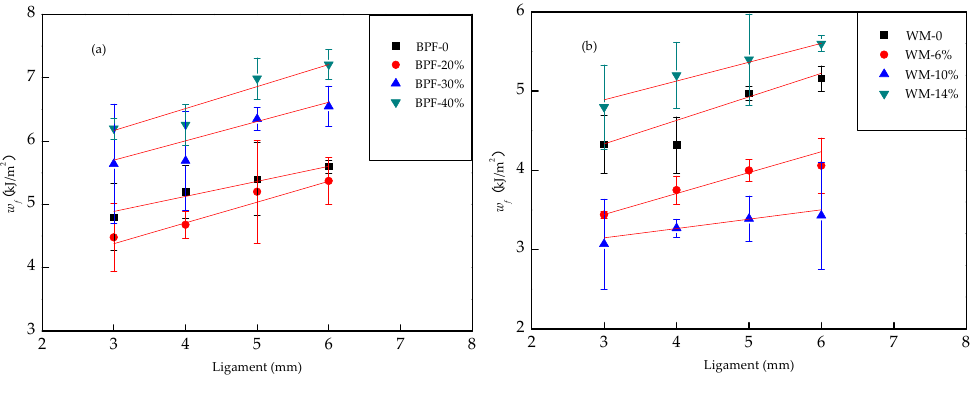
Figure 7. w f versus l ( a ) BPF ‐ filled BPCs; ( b ) WM ‐ filled BPCs. Table 5. Fracture parameters for the BPCs specimens.